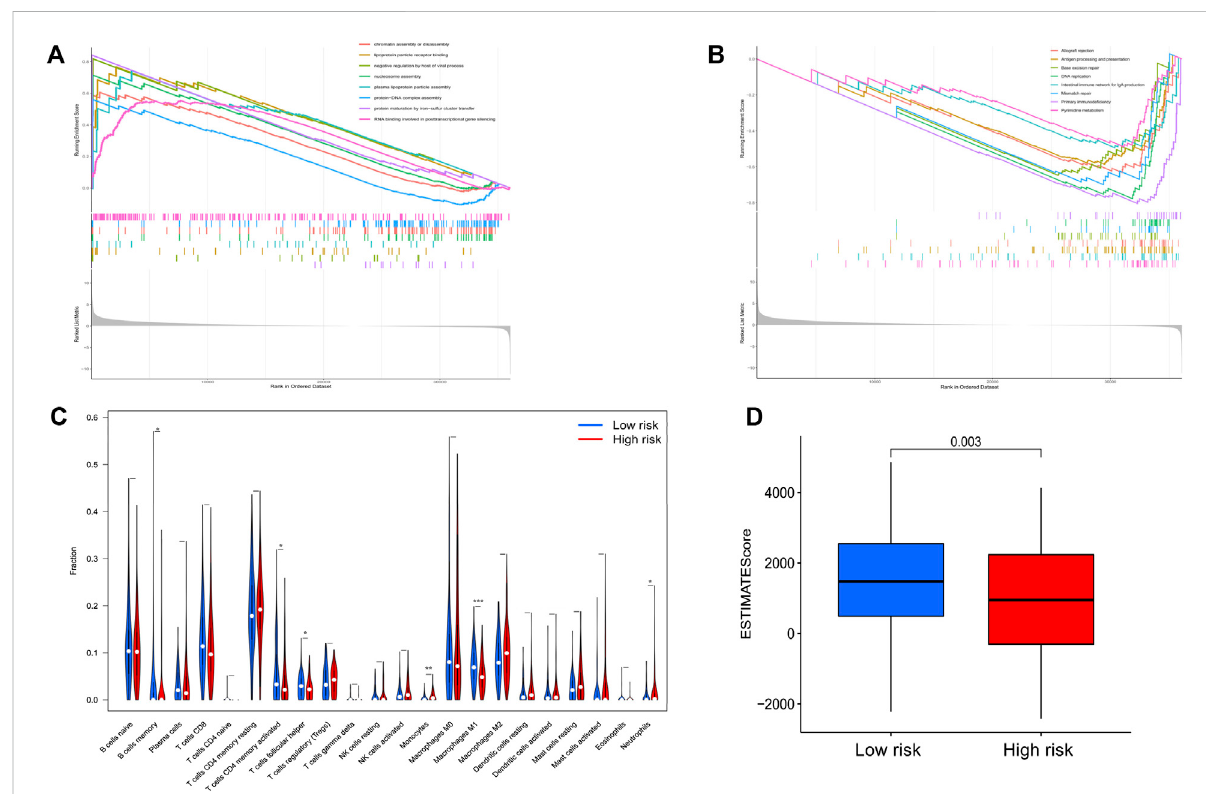
FIGURE 5 (A,B) Functional enrichment analysis of the two risk groups by GSEA. (C,D) Assessment of the correlation between the risk score of the GC patients and the complex immune in fi ltration level. (C) Violin plot displayed the distribution of diverse immune cell invasions in the high-GC risk and low-GC risk groups. (D) The ESTIMATE Score in different risk groups. The red group designates the high-GC risk group, whilst the blue group represents the low-GC risk group. GC, gastric